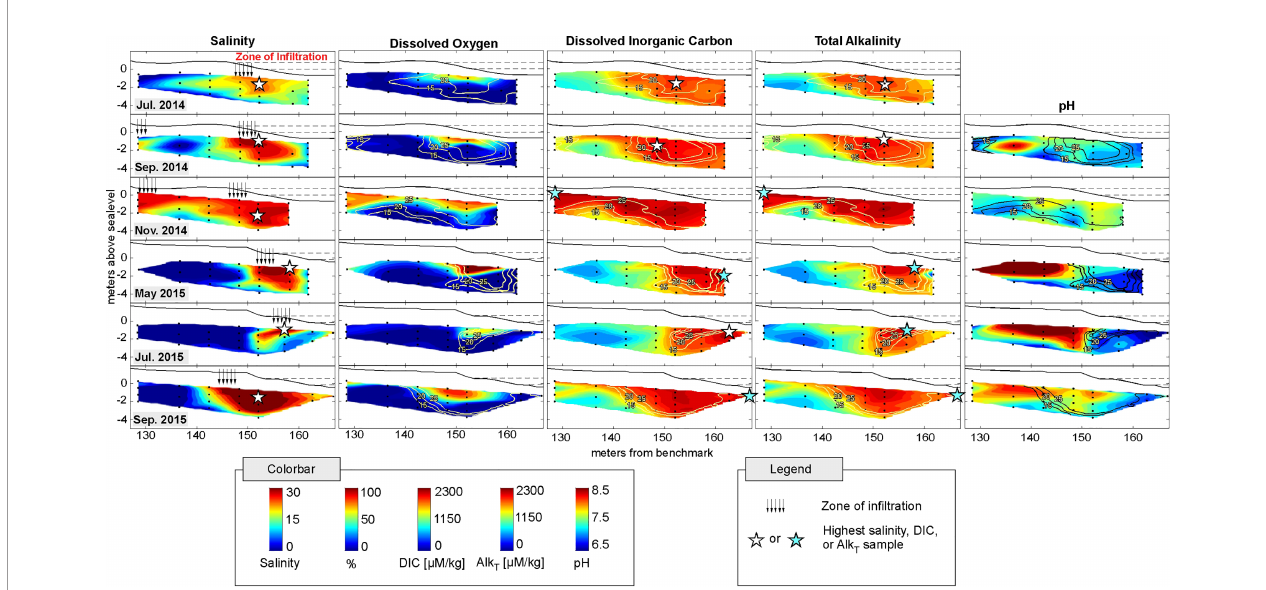
FIGURE 2 | Cross-sectional distributions of salinity, dissolved oxygen saturation %, DIC, Alk T , and pH in the Cape Shores intertidal zone for 6 sampling events. Black solid line indicates topography, with mean high-tide and mean sea-level indicated with dotted horizontal lines. Black dots show sampling locations. Black arrows in Salinity panels indicate zone of saline in fi ltration. 15, 20, and 25 salinity contours are shown in yellow. Highest salinity, DIC, and Alk T concentrations in each panel are indicated with a star (color varied for visibility). The highest salinity sample does not always correspond to the highest DIC or Alk T sample, indicating active biogeochemical processes affecting DIC and Alk T within the intertidal